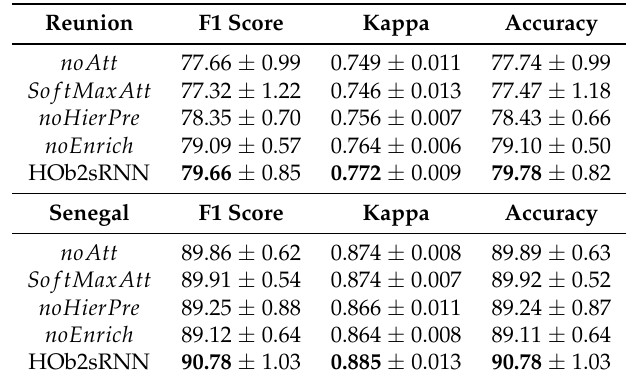
Table 8. F1 score, Kappa, and Accuracy considering different ablations of HOb2sRNN on the study sites (results averaged over ten random splits). We have highlighted the best scores in bold.